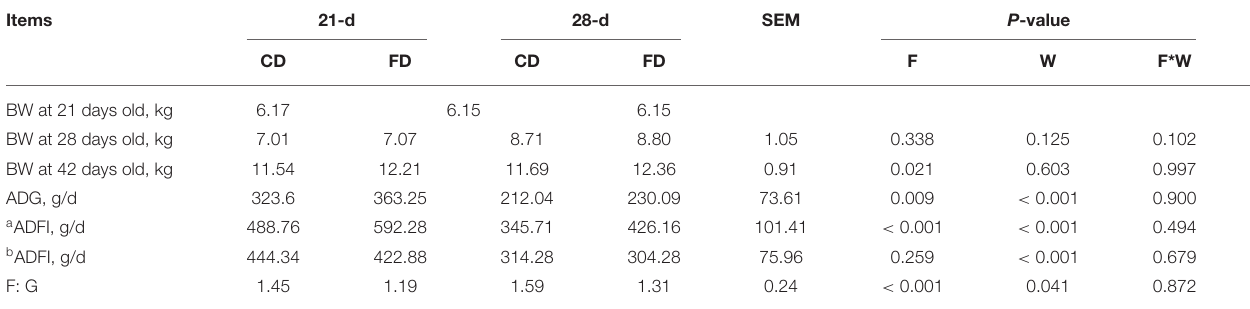
TABLE 4 | The effects of fermented diet and weaning age on the growth performance of piglets. Items 21-d 28-d SEM P -value CD FD CD FD BW at 21 days old,